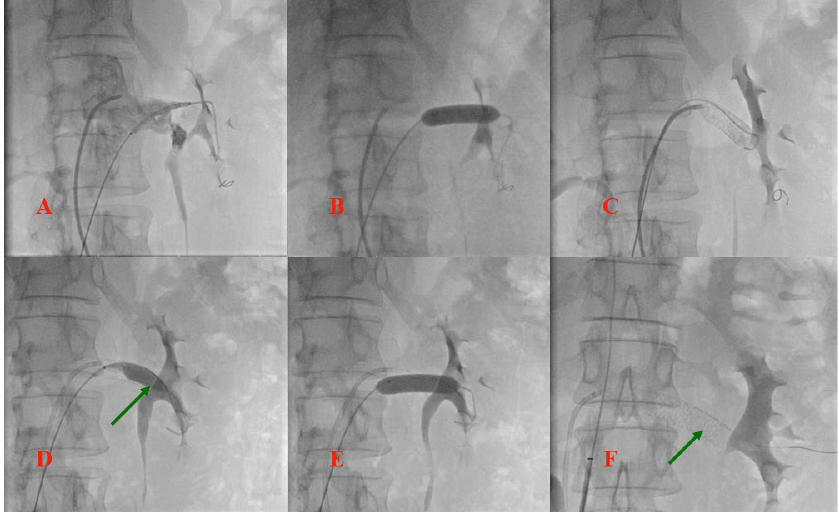
Figure 3. Left renal vein angioplasty-initial procedure. ( A ) Stent placement at the ostium of the LRV. ( B ) Stent inflation. ( C ) Stent partially migrated toward left kidney. ( D ) Stent repositioning using a partially inflated balloon. ( E ) Stent repositioned at the ostium of the vessel and balloon inflation (arrow). ( F ) Final result, with the stent partially migrated again towards LRV (arrow).